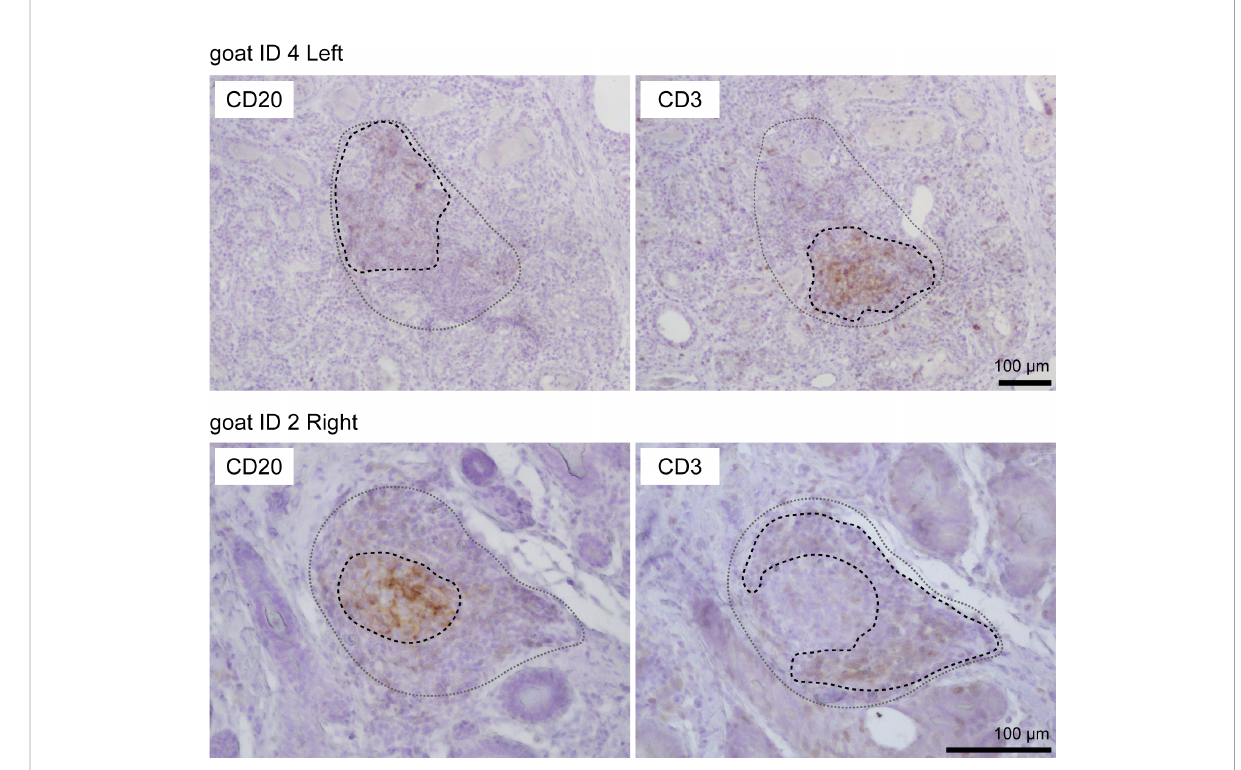
FIGURE 3 Representative images of immunohistochemistry against CD20 (B cells) and CD3 (T cells) in large aggregations of lymphocytes in goat mammary glands. Images of the same position are shown. Scale bar, 100 m